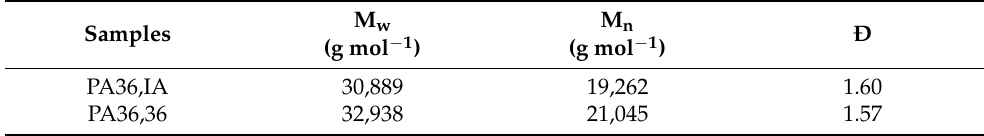
Figure 4. ( a ) GPC, ( b ) TGA, ( c ) DTG, and ( d ) DSC traces for the synthesized PAs. Table 1. The M w and M n of the synthesized PAs.